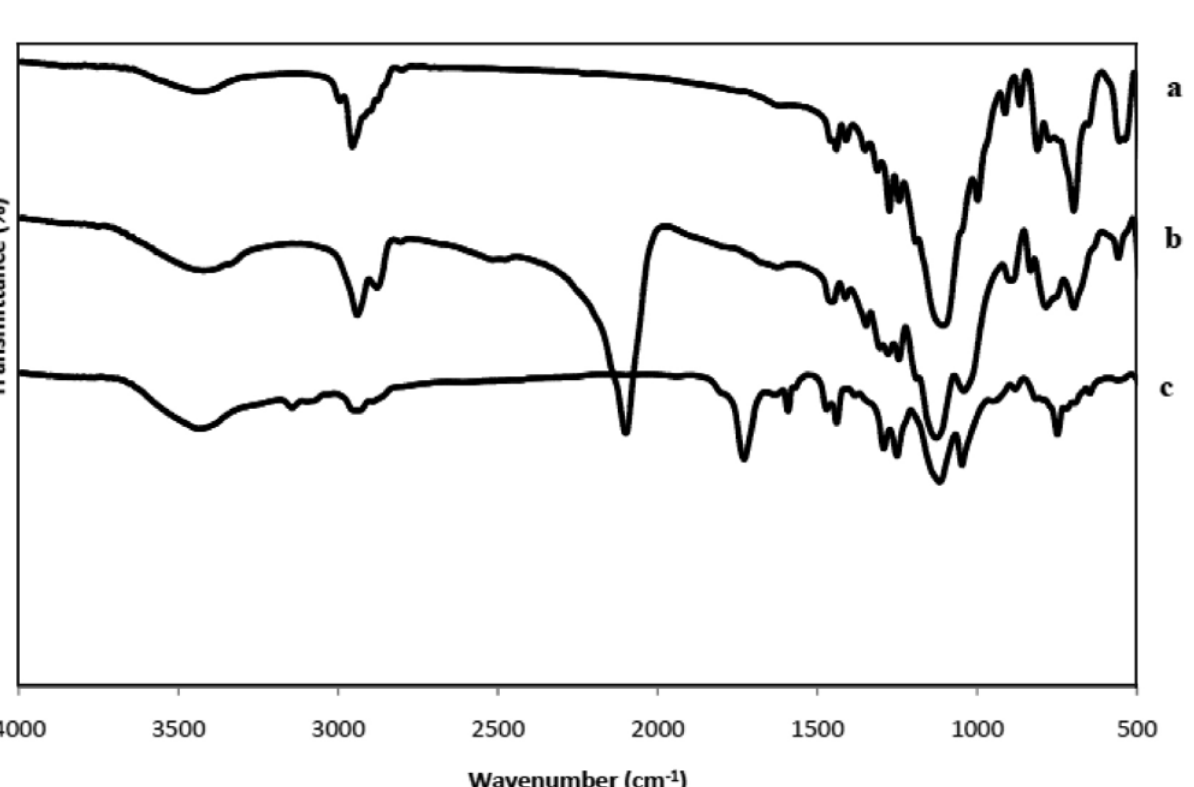
Figure 3. FT-IR spectra of (a) POSS-(Cl)